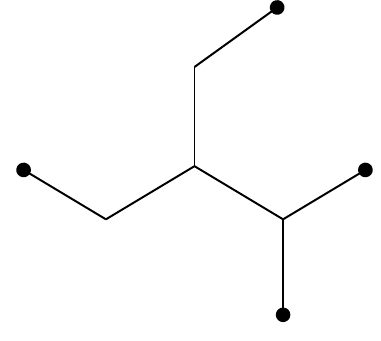
Figure 5: A hexagonal Steiner